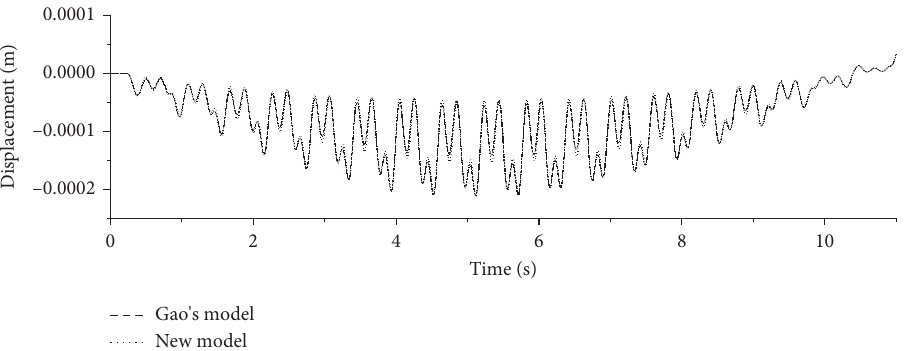
Figure 8: Displacement at beam mid-span (initial vector